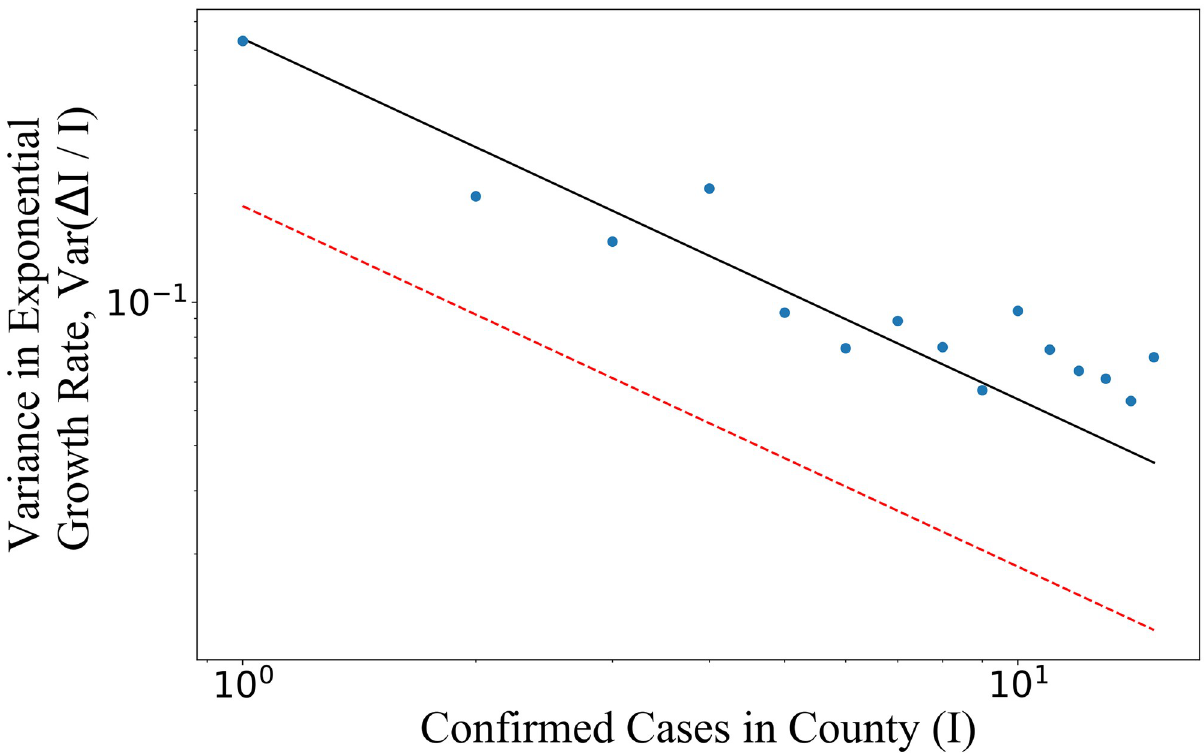
Fig 2. As the number of infections I in a given county increases, the variance in exponential growth rate, Var( Δ I / I ),decreases as ð m data point at a given I is calculated by taking the sample variance in Δ I / I across all counties when they have I cases. We observe that the USA data (blue) is inconsistent with a model of uniform infectiousness, or σ β = 0 (dashed red line). A fit to the data (solid black line) implies a large variance in infectiousness, such that σ β / μ β ≳